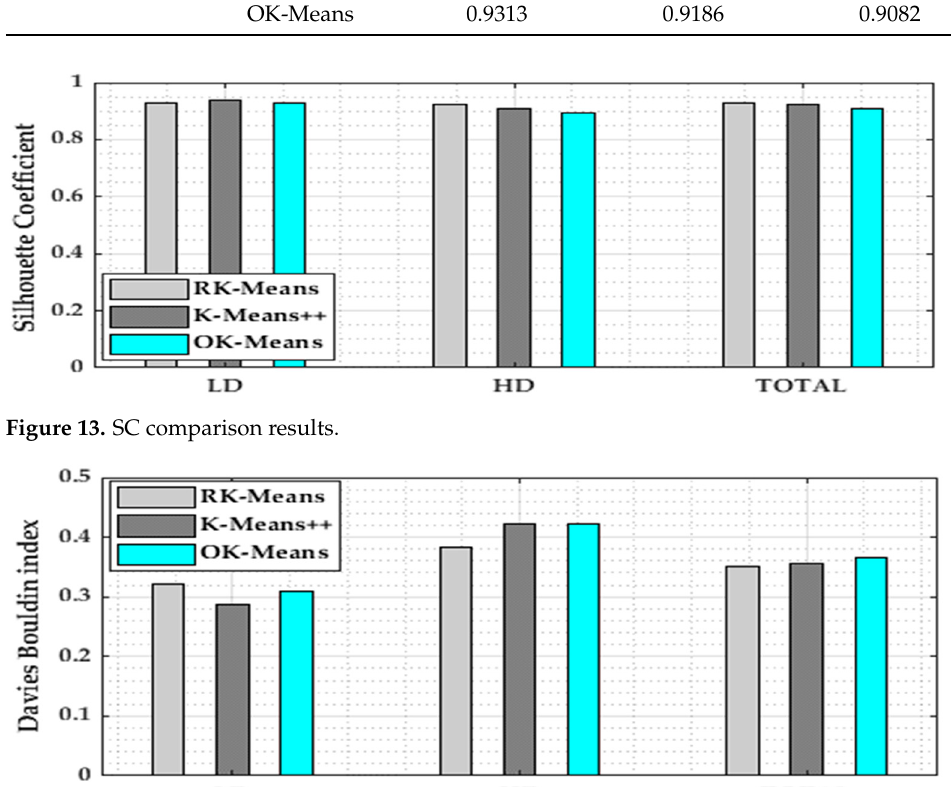
Figure 14. DB comparison results.